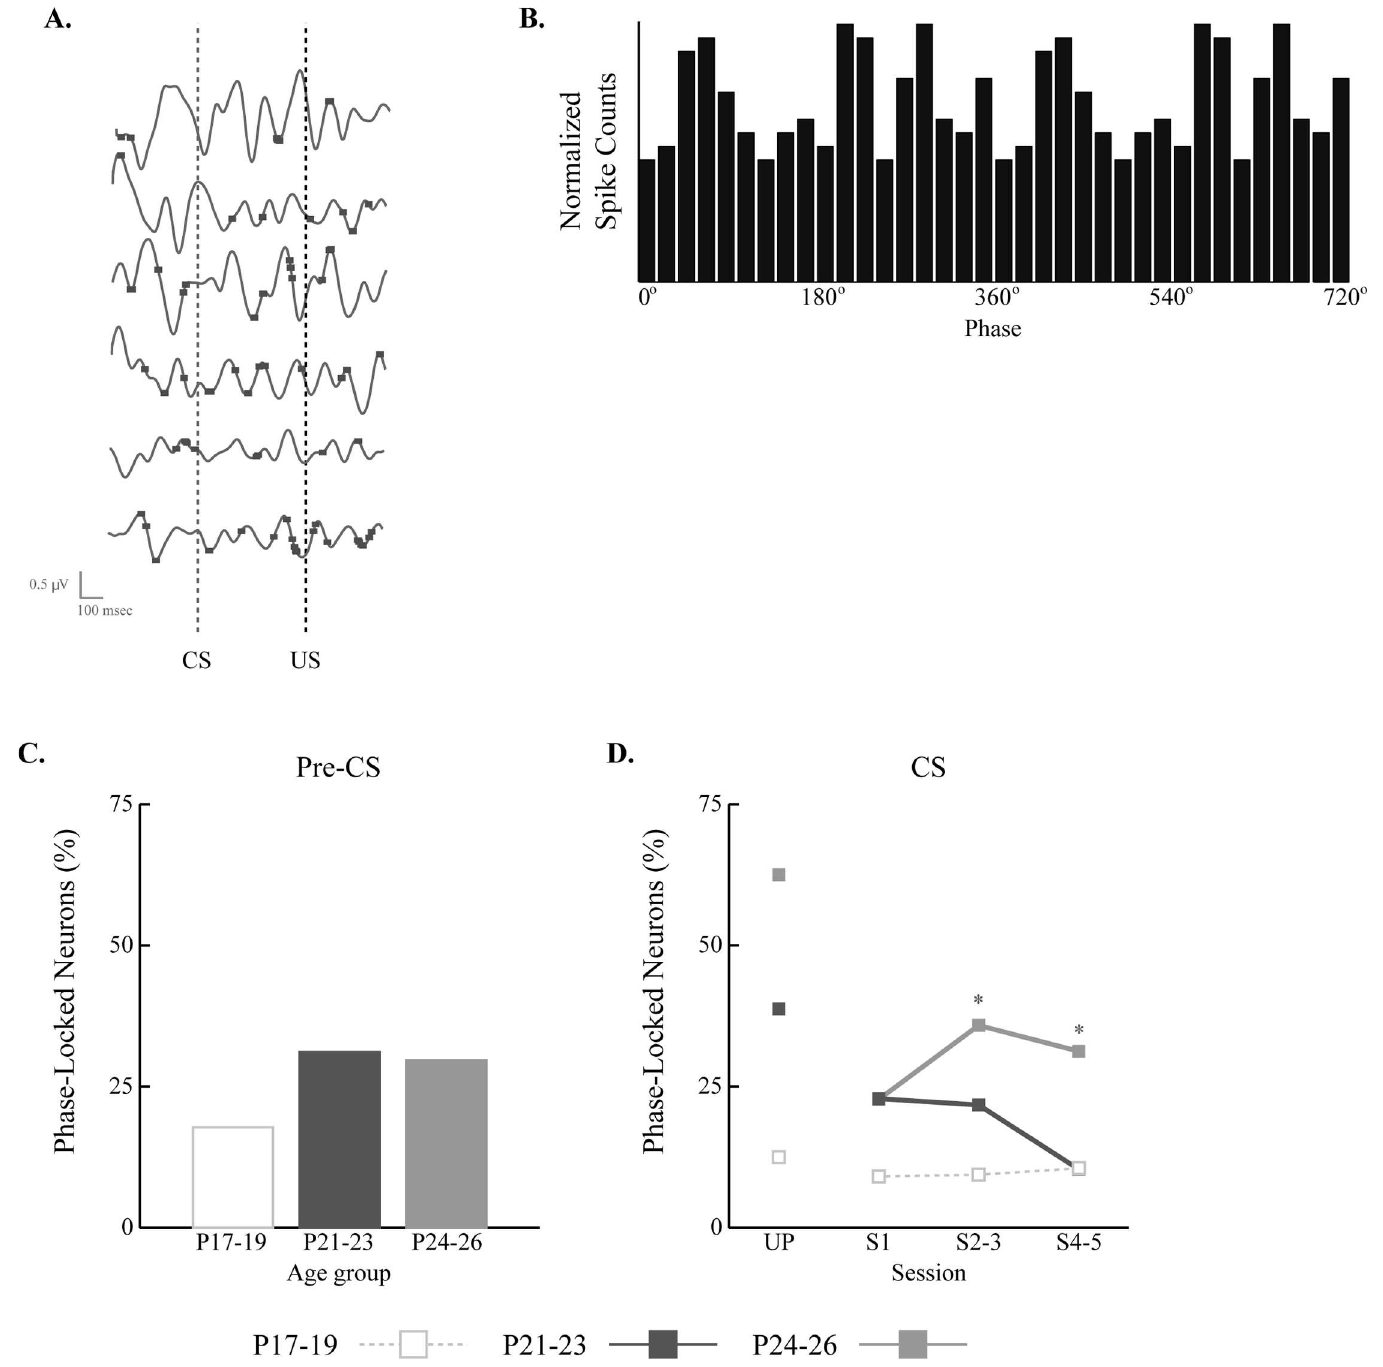
Fig 10. CA1 spike-theta phase relationships. A. Representative examplesof theta and simultaneously recordedCA1 firing from a session. Horizontal and vertical axes of the scale represent time and the amplitudelevel of the EEG, respectively. B. The distribution of firing phases during the cycles of theta. The statistical significance of the distributionwas tested with Rayleigh’s circular data test (alpha = 0.05). C and D. Percentage of neuronswith significant phase-locking in rat pups given eyeblinkconditioning on postnatal days (P) 17–19, P21-23 or P24-26 in the pre-CS and CS periods. The proportion of CA1 neuronsthat showed significant phase-locking with theta showed both developmental and